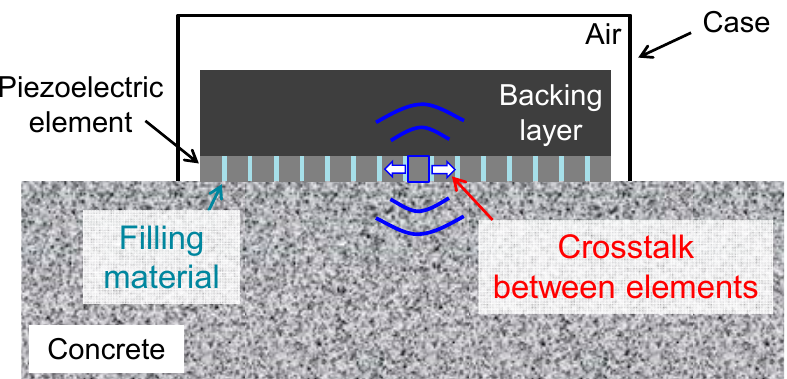
Figure 1. Structure of conventional array transducer with filling material and backing layer.